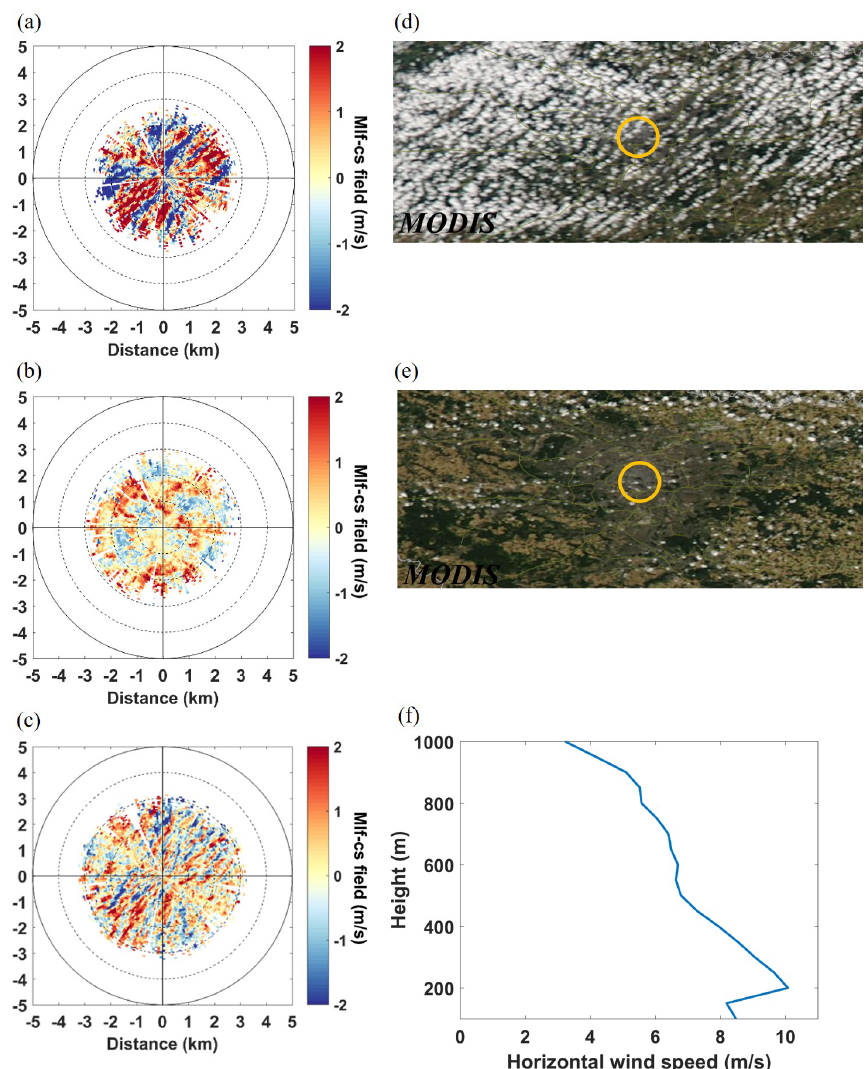
Figure 5. The upper part shows the three types of mlf-cs fields to classify: (a) rolls observed on 13 October 2014 at 12:52UTC, (b) unaligned thermals observed on 16 September 2014 at 12:52UTC and (c) streaks observed on 9 September 2014 at 20:49UTC. The lower part shows the ancillary observations used to ascertain the structure type: (d) and (e) are true-colour images recorded by MODIS Aqua on the same day as (a) and (b) at 12:50UTC, and (f) is the horizontal wind speed profile recorded by the Doppler lidar using the DBS technique on the same day as (c) at